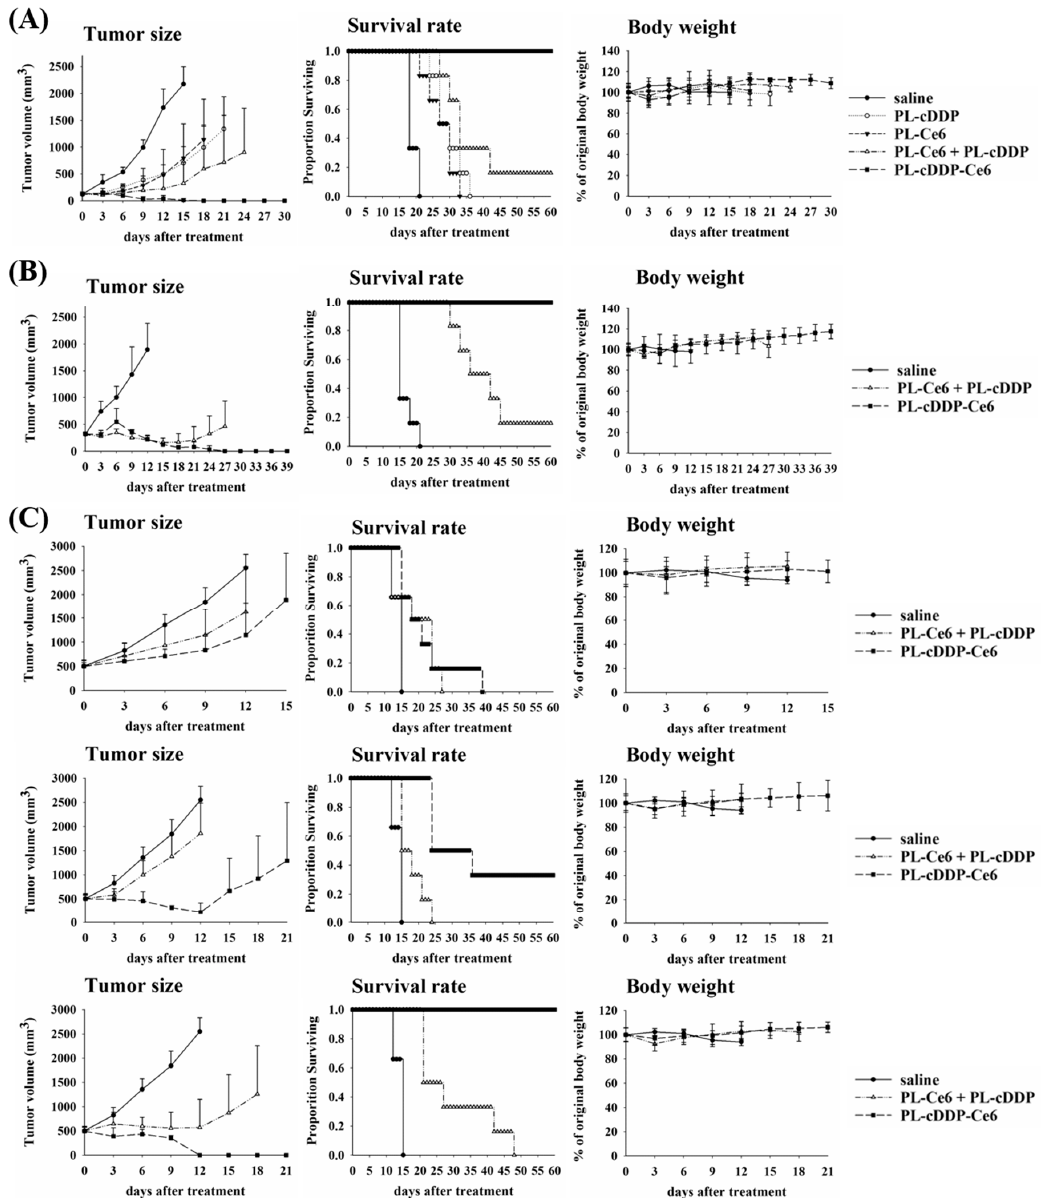
Figure 7. Therapeutic efficacy of mice bearing different sizes of C26 tumor. A single dose of PL-cDDP-Ce6 was intravenously injected to the animals of each group ( N = 6). After drug administration, two doses of light irradiation (100 J/cm 2 ) were applied onto the tumor at 2 and 12 h. ( A ) The average size of the initial tumor was 100 mm 3 before drug administration (Ce6: 1.75 mg/kg; cDDP: 3.73 mg/kg). ( B ) The average size of the initial tumor was 300 mm 3 before drug administration (Ce6: 1.75 mg/kg; cDDP: 3.87 mg/kg). Left panel, tumor size; Middle panel, Survival rate; Right panel, body weight. ( C ) Survival rate of PL-cDDP-Ce6 increases in a dose-dependent manner in mice bearing a tumor with an average initial size of 500 mm 3 . The dose of Ce6 administrated in mice was 1.75 mg/kg and the dose of cDDP varied under the doses of 3.83 mg/kg (upper panel), 4.75 mg/kg (middle panel) and 5.71 mg/kg (lower panel). The results are represented as the mean ± S.D. for each group.